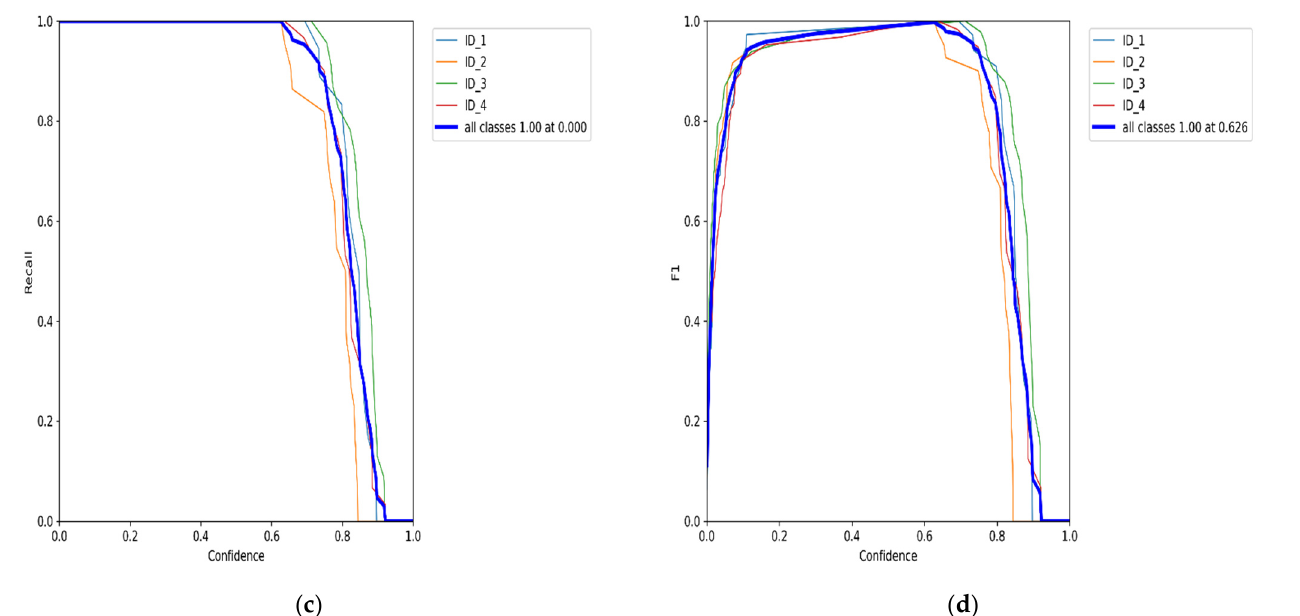
Figure 7. The label ( a ) shows the precision(P) versus confidence(C) graph, ( b ) the recall(R) versus confidence(C), ( c ) is the mean average precision(mAP) based on comparing the truth bounding box and detection box, and ( d ) the IDF1 score at 100% with confidence of 0.626, which advocates the balance between P and R based on passageway scenes dataset. The mAP for all classes is high and accurately modeling detections at 95.1% with a threshold of 0.5. The P and R are high at 100% and 100%, respectively, and more confidence at 0.713 and 0.0 respectively for all classes .